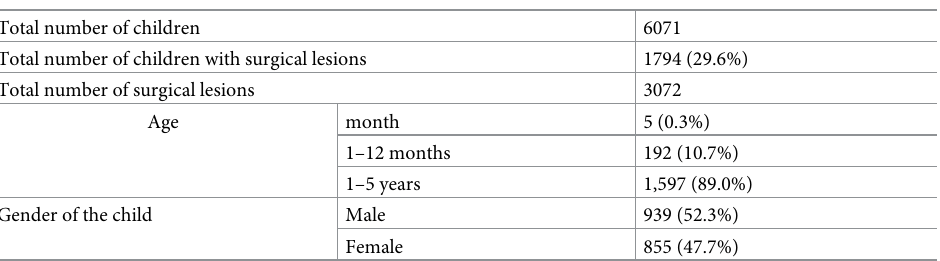
Table 2. Details of children with lesions.